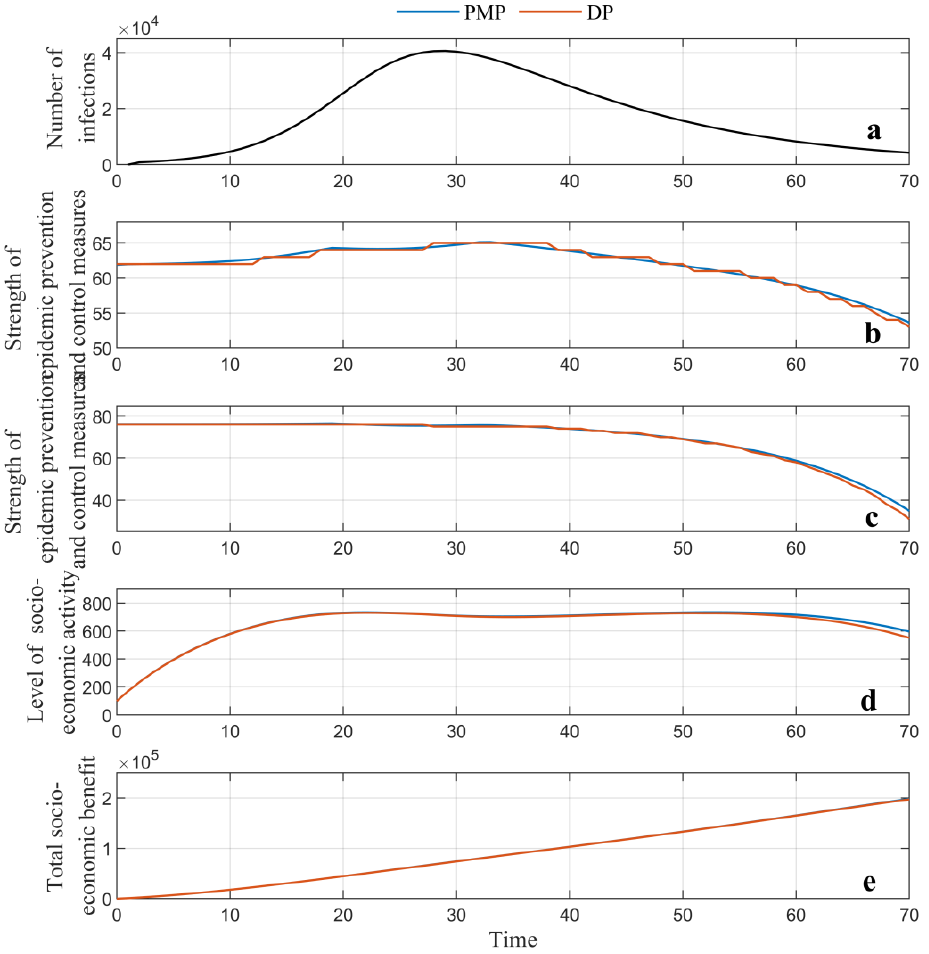
Figure 6. Results of the dynamic strategy generated by dynamic programming and Pontryagin’s minimum principle: ( a ) forecasted number of infections; ( b ) optimal trajectory of strength of the pandemic prevention and control measures; ( c ) optimal trajectory of economic stimulus; ( d ) optimal trajectory of the level of socio-economic activity; ( e ) total socio-economic benefit.